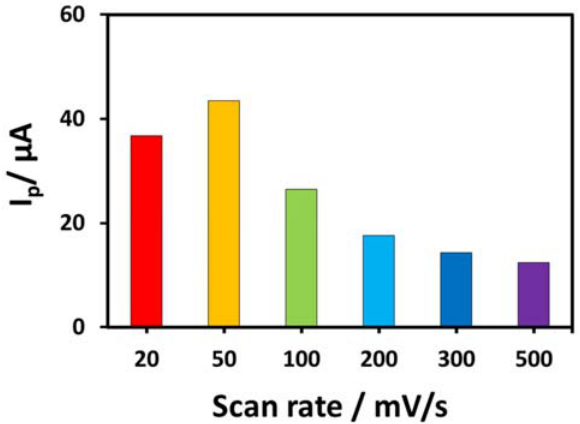
Figure 6: Histograms showing the effect of pretreatment scan rate on the detection of 6.2 × 10 –7 mol/L Hg(II) in 0.1 mol/L acetate buffer (pH 5.5) at GPE surfaces. Pretreatment CV segments, 20; ot- her working conditions are described in Fig. 4a.